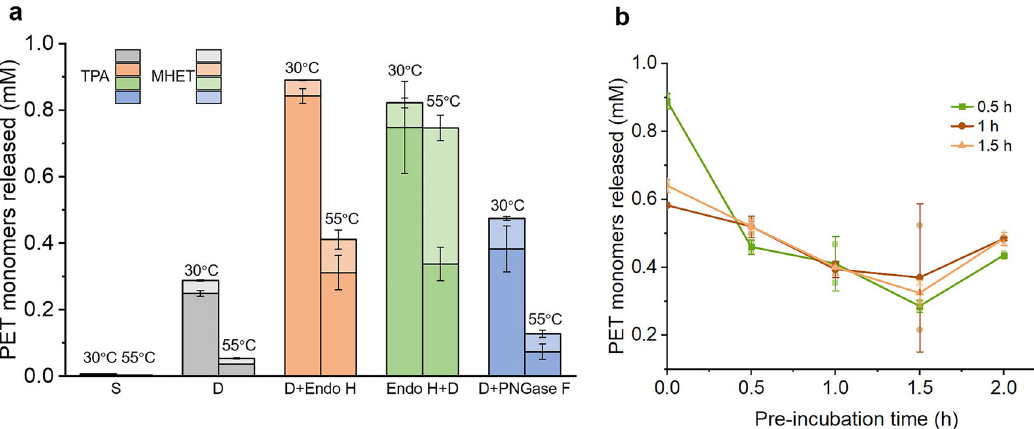
Fig. 3 Optimization of the conditions for the deglycosylation of Is PETase- Pp . a The enzymatic activity of Is PETase- Pp with or without deglycosylation. S: the supernatant of the high-density fermentation; D: dialyzed supernatant of the high-density fermentation; D + Endo H: dialyzing prior to deglycosylation with Endo H; Endo H + D: deglycosylation with Endo H prior to dialyzing, D + PNGase: dialyzing prior to deglycosylation with PNGase F. 30 °C indicates the hydrolytic activity of the samples measured at 30 °C; 55 °C indicates the residual activity after incubated at 55 °C for 1 h. To analyze the enzyme activity, 0.4 mg of enzyme and 3 mg of amorphous PET were incubated in 1 mL of 50 mM glycine-NaOH buffer (pH 9.0) for 6 h at 30 °C. b The enzyme activity of Is PETase- Pp after treated with Endo H for 0.5, 1.0 and 1.5 h. The thermostability were measured after the samples were incubated at 55 °C for 0, 0.5, 1, 1.5, and 2 h. Data are presented as mean ± SD.